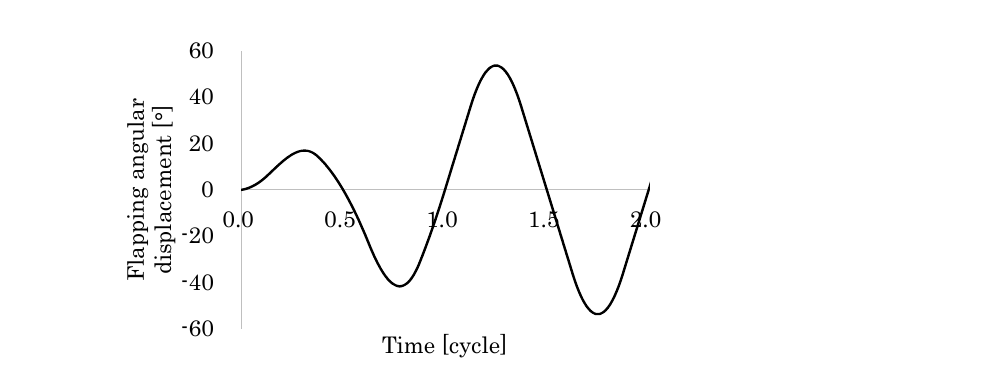
Figure 6. Geometry of the fluid domain and the employed mesh: ( a ) The geometry of the fluid domain (dynamically scaled); ( b ) The xz — plane view; ( c ) The yz — plane view, where the colored domain shows the wing’s mesh; ( d ) The xy — plane view. The number of fluid elements is 1,578,960 and the number of fluid nodes is 276,138.